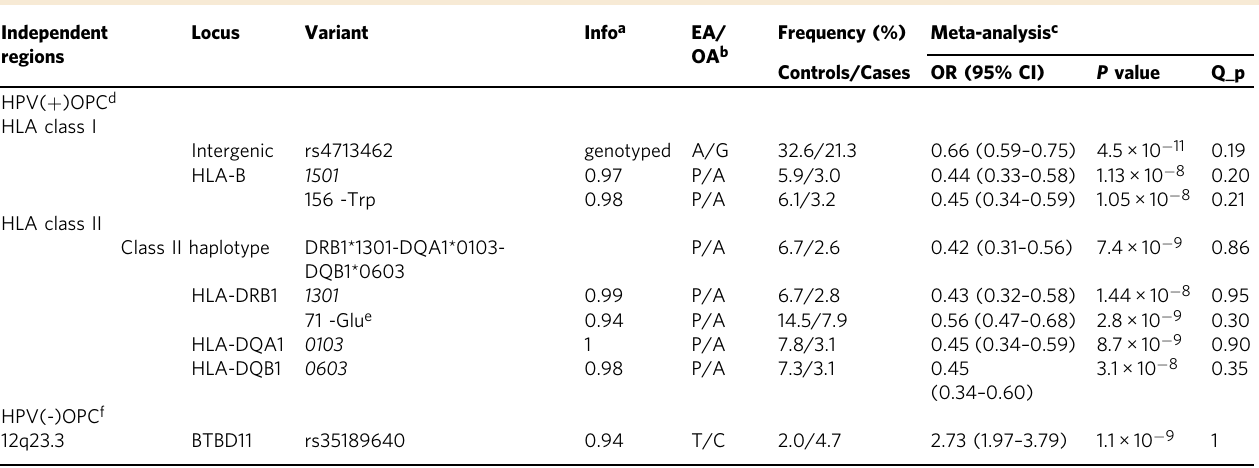
HLA human leukocyte antigen, OR odds ratio, 95% CI con fi dence interval, Q_p Cochran ’ s heterogeneity p value a Imputation INFO (R2) is the average across imputation